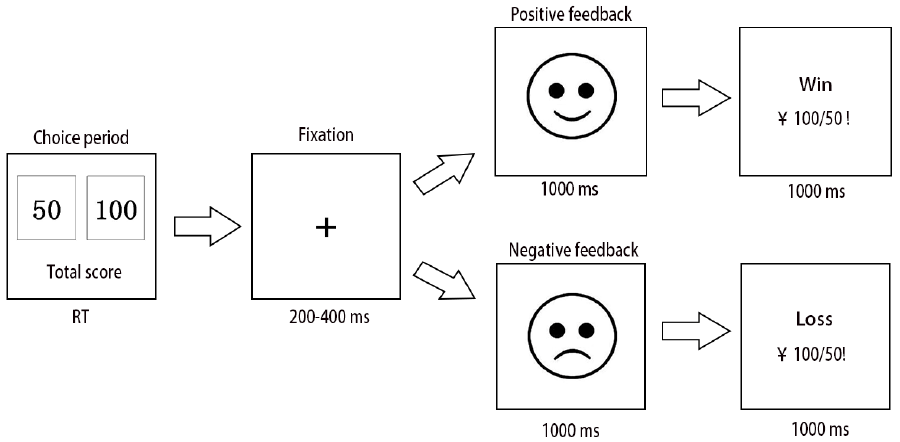
Figure 2. Illustration of the revised Iowa gambling task (IGT). There were two keys corresponding to two choices, and participants were asked to make 300 choices. After participants made a button response, it was followed by a 200–400 ms fixation point. After the fixation, a cartoon face persisted as feedback indicating whether they lost or won in the trial. Subsequently, a numerical stimulus popped up on the computer screen to indicate the selected consequence, which lasted for 1000 ms.